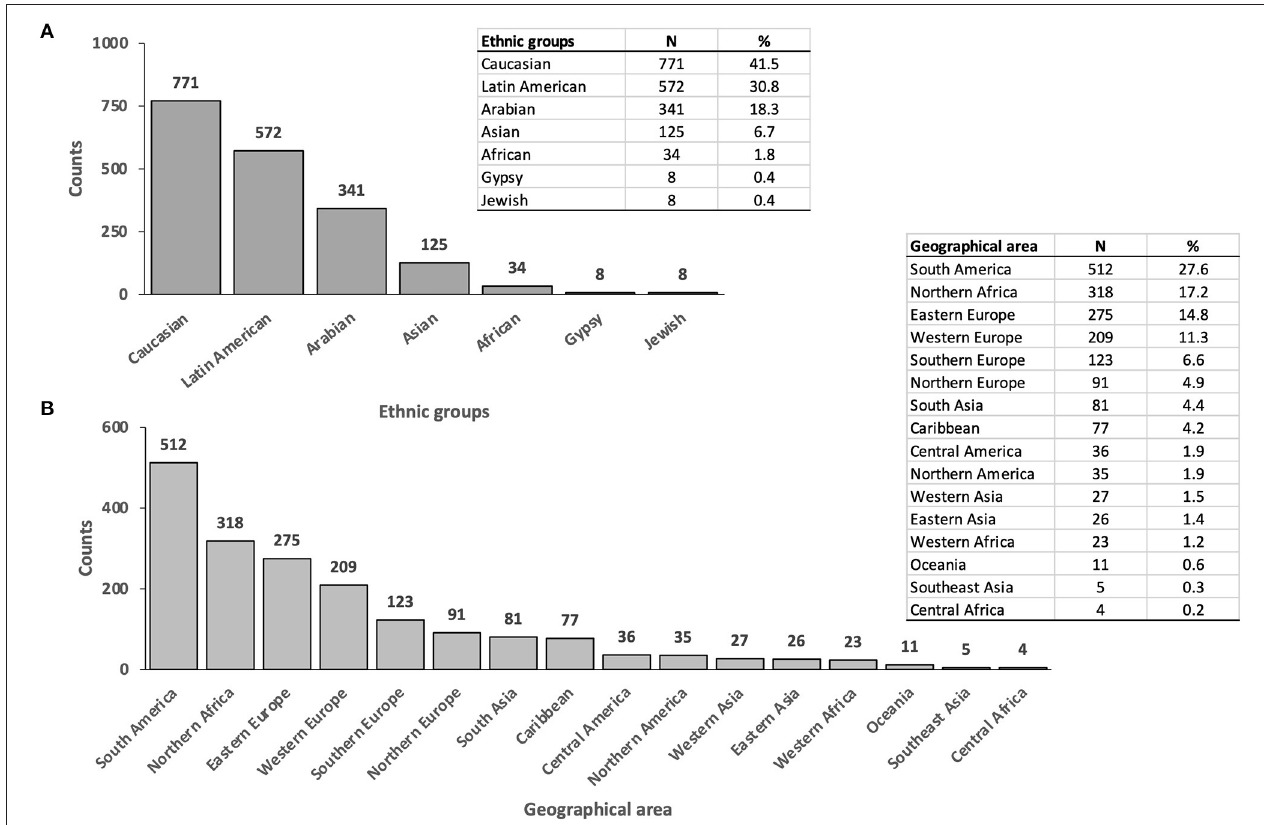
FIGURE 1 | (A) Distribution of immigrant population by ethnicity. (B) Distribution of immigrant population by geographical area of birth according to OMS Standard Country or Area Codes for Statistical Use, M49 standard.